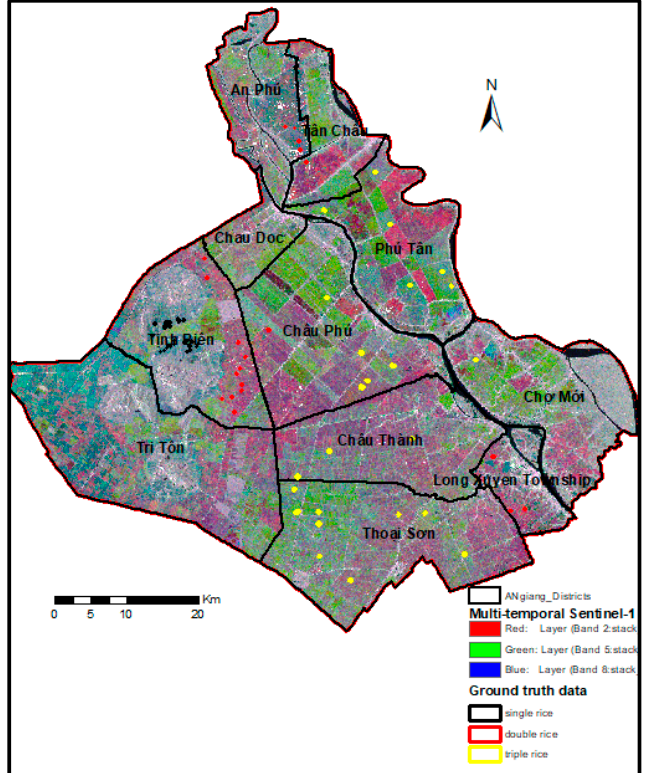
Figure 5. Multitemporal Sentinel-1A data color composite with training polygons overlaid. R:G:B = HV2017.03.13: HV2017.03.25: HV 2017.04.06.